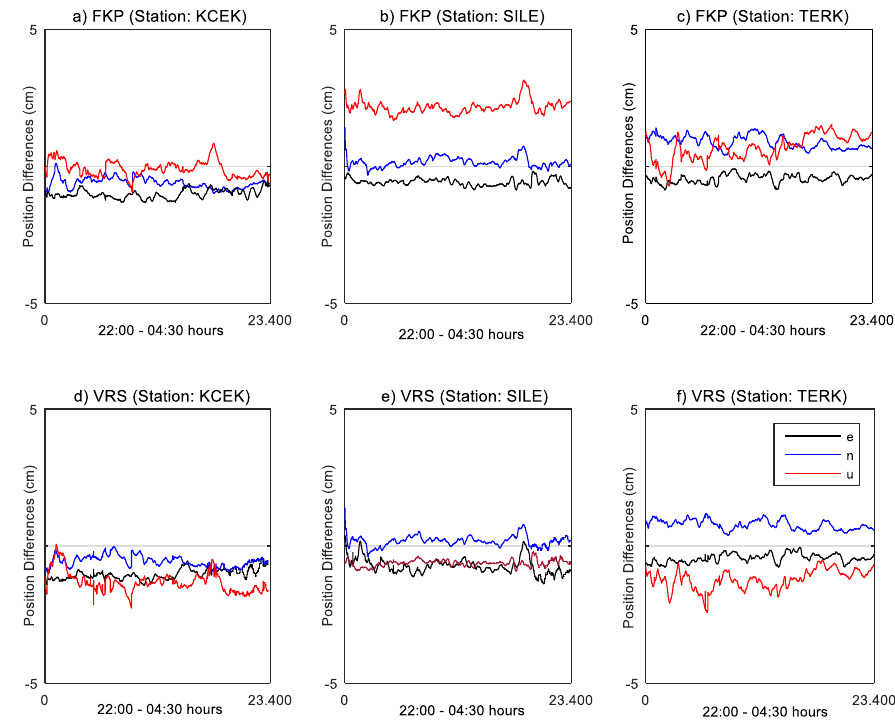
Figure 6. The NRTK position di ff erences at stations with a short baseline length (( a – c ) are FKP results. ( d – f ) are VRS results).